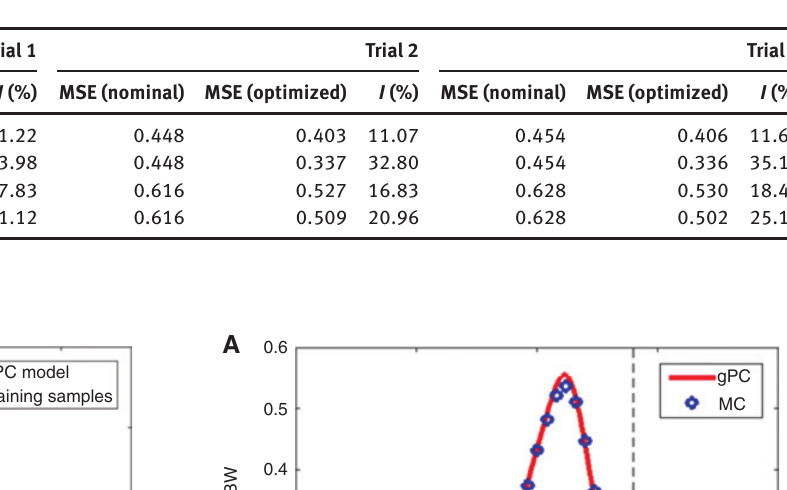
Table 2: MSEs of unoptimized nominal design and optimized nominal design under process variations in cases A to D. Each trial has 5000 independent Monte Carlo samples.